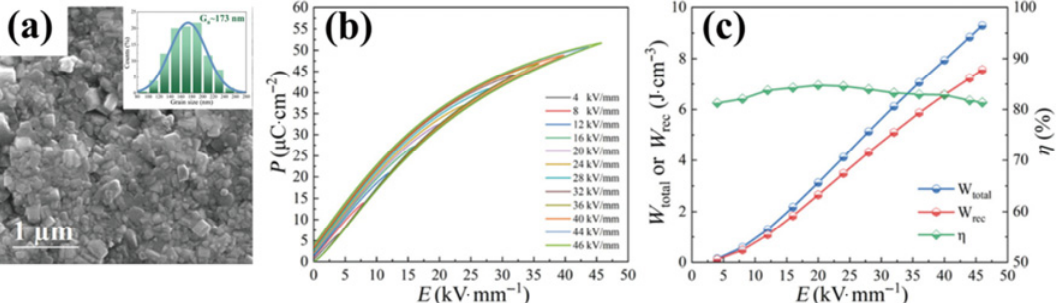
Fig. 16 (a) SEM image of 0.6BKT–0.3BT–0.1NN ceramics. (b) P – E loops and (c) energy storage performance of 0.6BKT–0.3BT–0.1NN ceramics. Reproduced with permission from Ref. [29], © Wiley-VCH GmbH